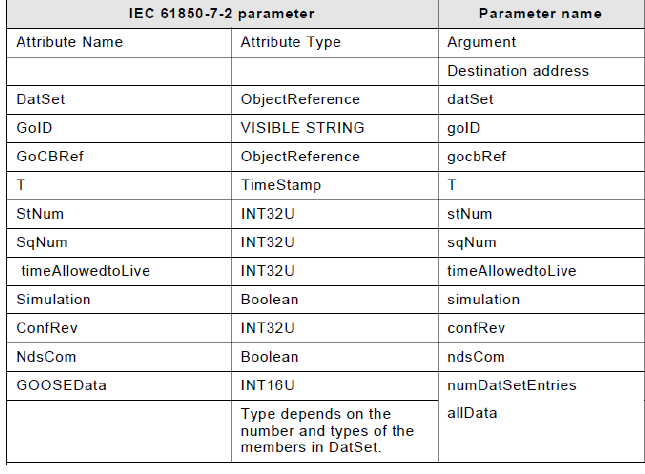
Fig. 7. GOOSE service parameter